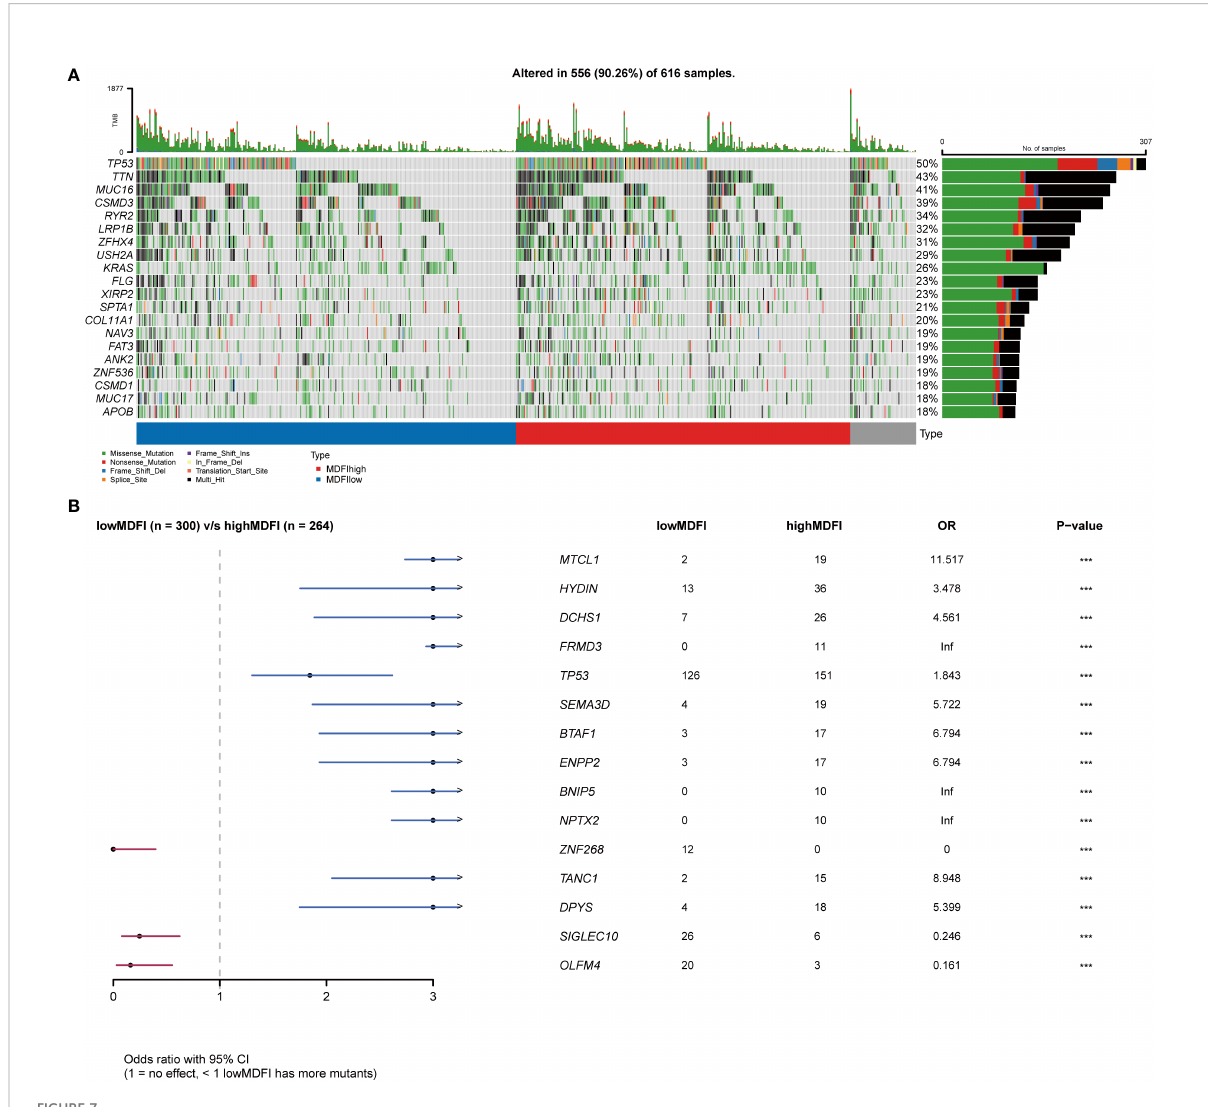
FIGURE 7 Relationship between MDFI and LUAD somatic mutation, data from TCGA. (A) Somatic mutation in MDFI-low and MDFI-high expression groups, (B) Comparison of mutation in MDFI high expression group and low expression group. ***p <